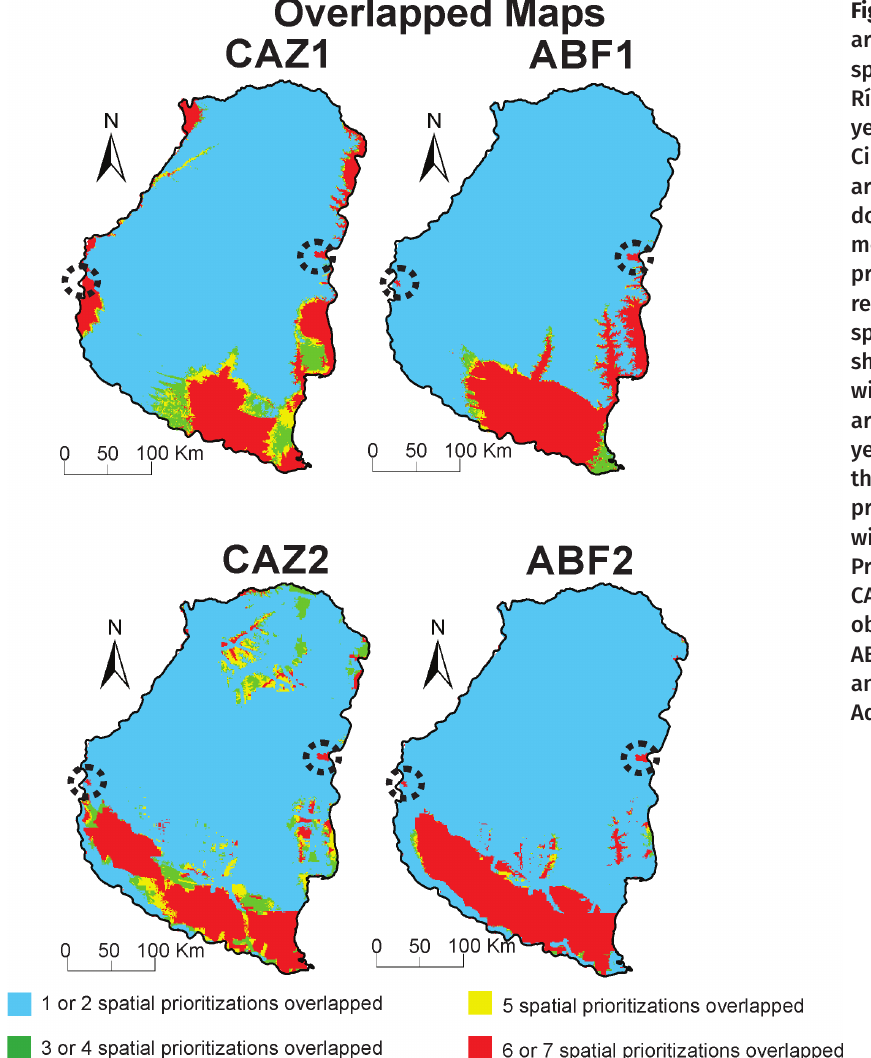
Figure 3. Spatial prioritization areas for the threatened bird species that inhabit Entre Ríos province considering years 2050-2070 and Global Circulation Models. PAs are represented in black dotted circles. Areas with more overlapped spatial prioritizations are shown in red; those with less overlapped spatial prioritizations are shown in blue and those with intermediate scores are depicted in green and yellow. CAZ 1: it includes the overlapped spatial prioritizations obtained with Core Area Zonation and Protected Areas Networks. CAZ 2: it includes CAZ 1 but obtained with Human Footprint. ABF 1 and ABF 2 are like CAZ 1 and CAZ 2 respectively but with Additive Benefit Function